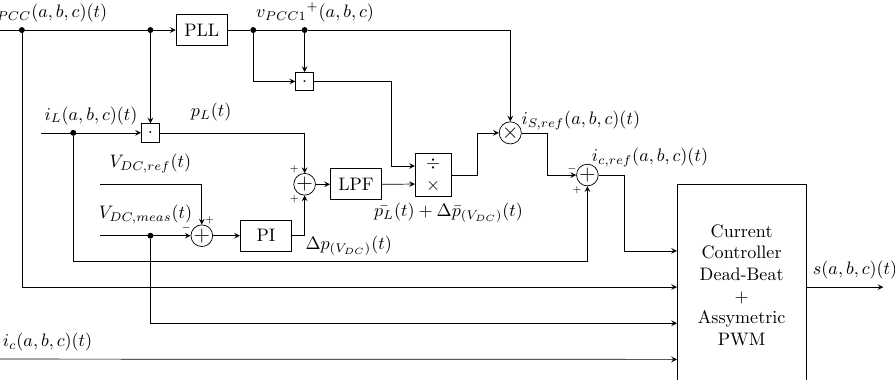
Figure 5. Diagram of Perfect Harmonic